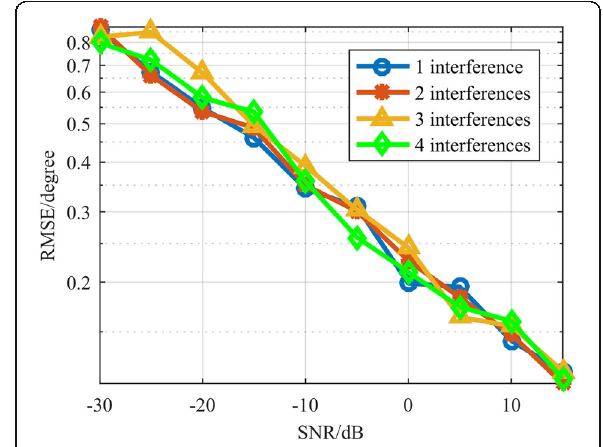
Fig. 6 RMSE versus number of snapshots, SNR = − 25 dB